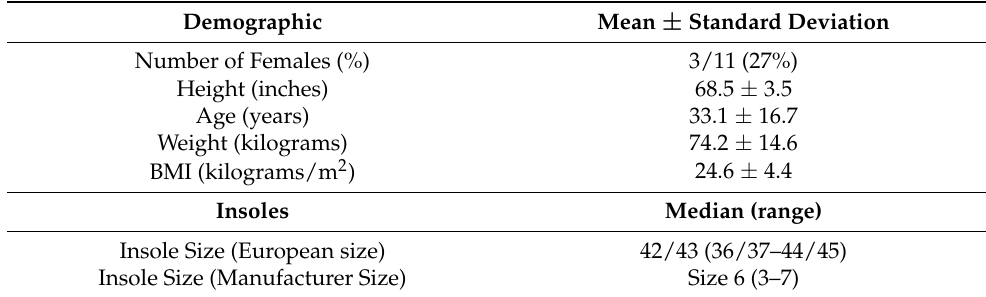
Table 1. Subject characteristics ( n = 11) and insole sizing. Each size of an Insole3 covers two European sizes (e.g., Size 4 covers European Sizes 38 and 39). The median European size was used for the insole size (e.g., for an individual wearing a Size 4 insole, their European insole size used was 42/43). Demographic Mean ± Standard Deviation Number of Females (%) 3/11 (27%) Height (inches) 68.5 ± 3.5 Age (years) 33.1 ± 16.7 Weight (kilograms) 74.2 ± 14.6 BMI (kilograms/m 2 ) 24.6 ± 4.4 Insoles Median (range) Insole Size (European size) 42/43 (36/37–44/45) Insole Size (Manufacturer Size) Size 6 (3–7)